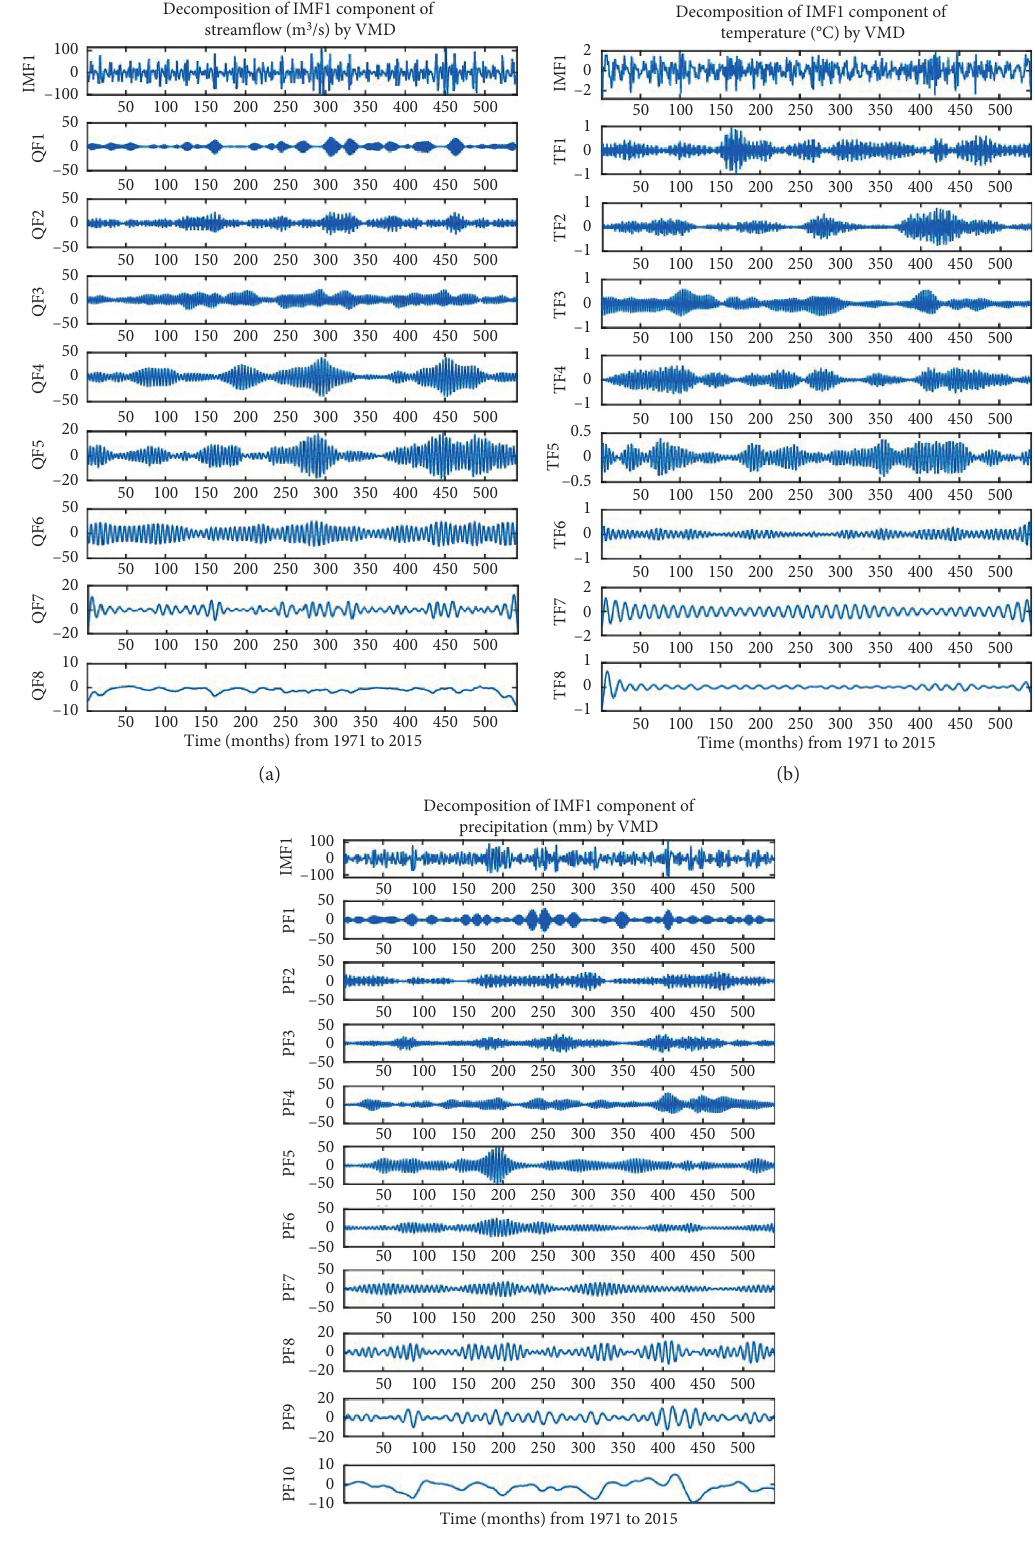
Figure 6: Decomposition of IMF1 component of ICEEMDAN by VMD. (a) Streamflow. (b) Temperature. (c)